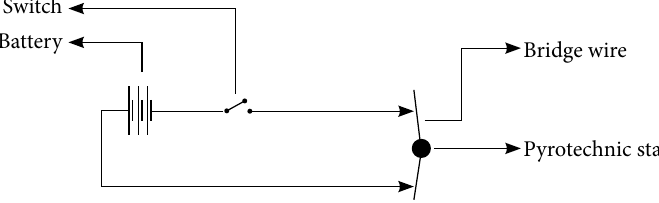
Figure 2. Line diagram of the electrical ignition